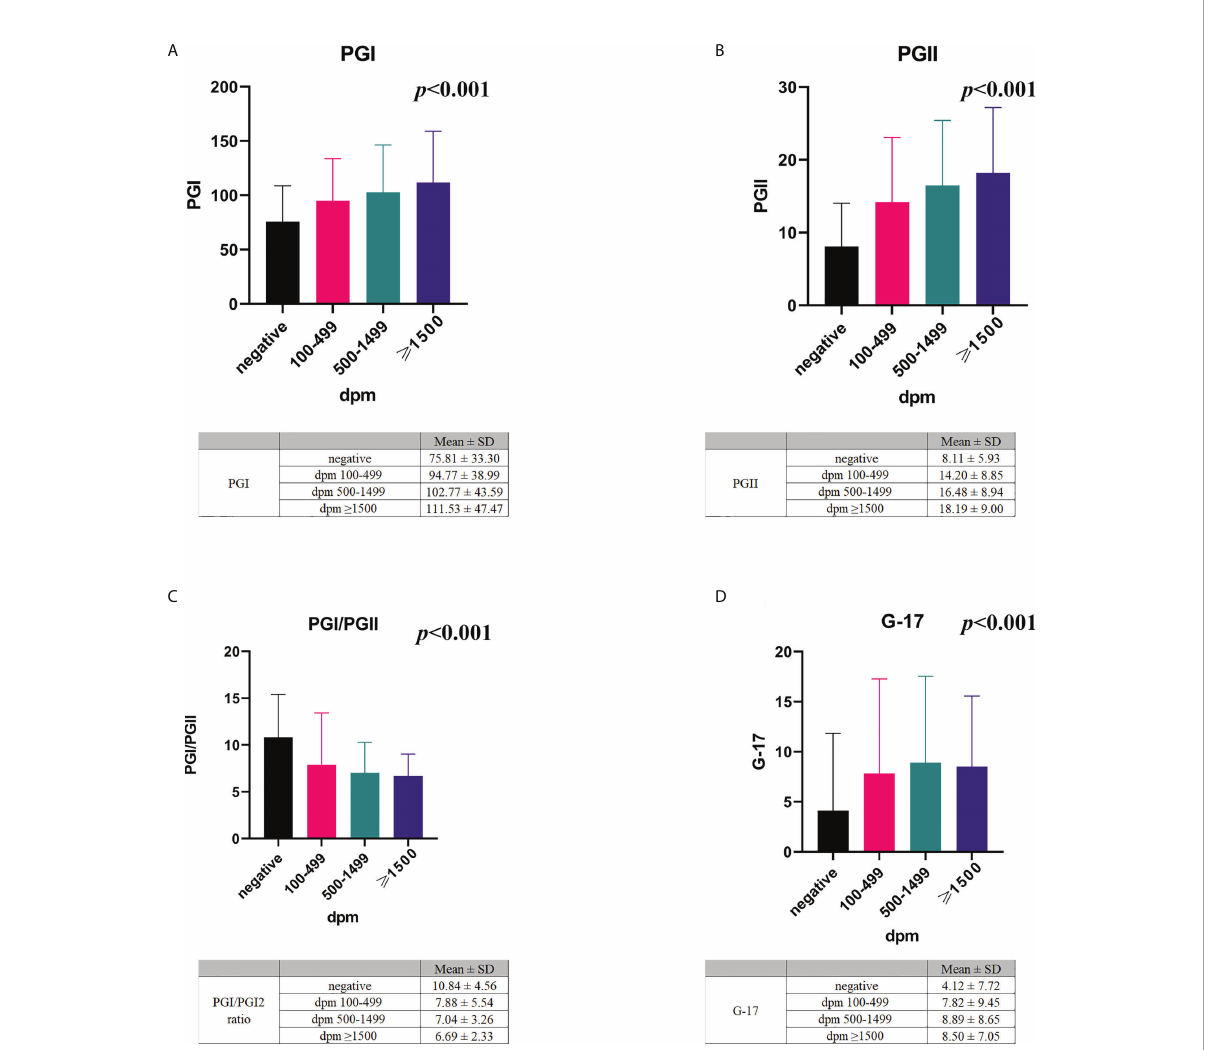
FIGURE 3 The association of serum PGs and G-17 with H . pylori infection. The mean serum levels of PGI (A) , PGII (B) , PGI/PGII ratio (C) , and G-17 (D) in H . pylori -negative and -positive subjects with different UBT values. PG, pepsinogen; G-17, gastrin-17; dpm, disintegrations per